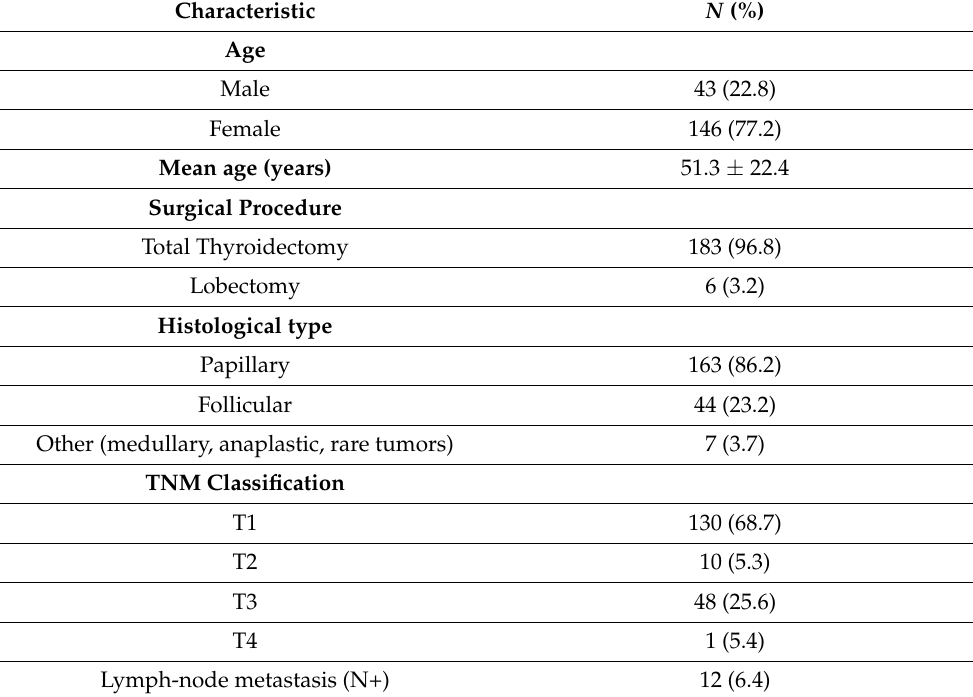
Table 1. Patients’